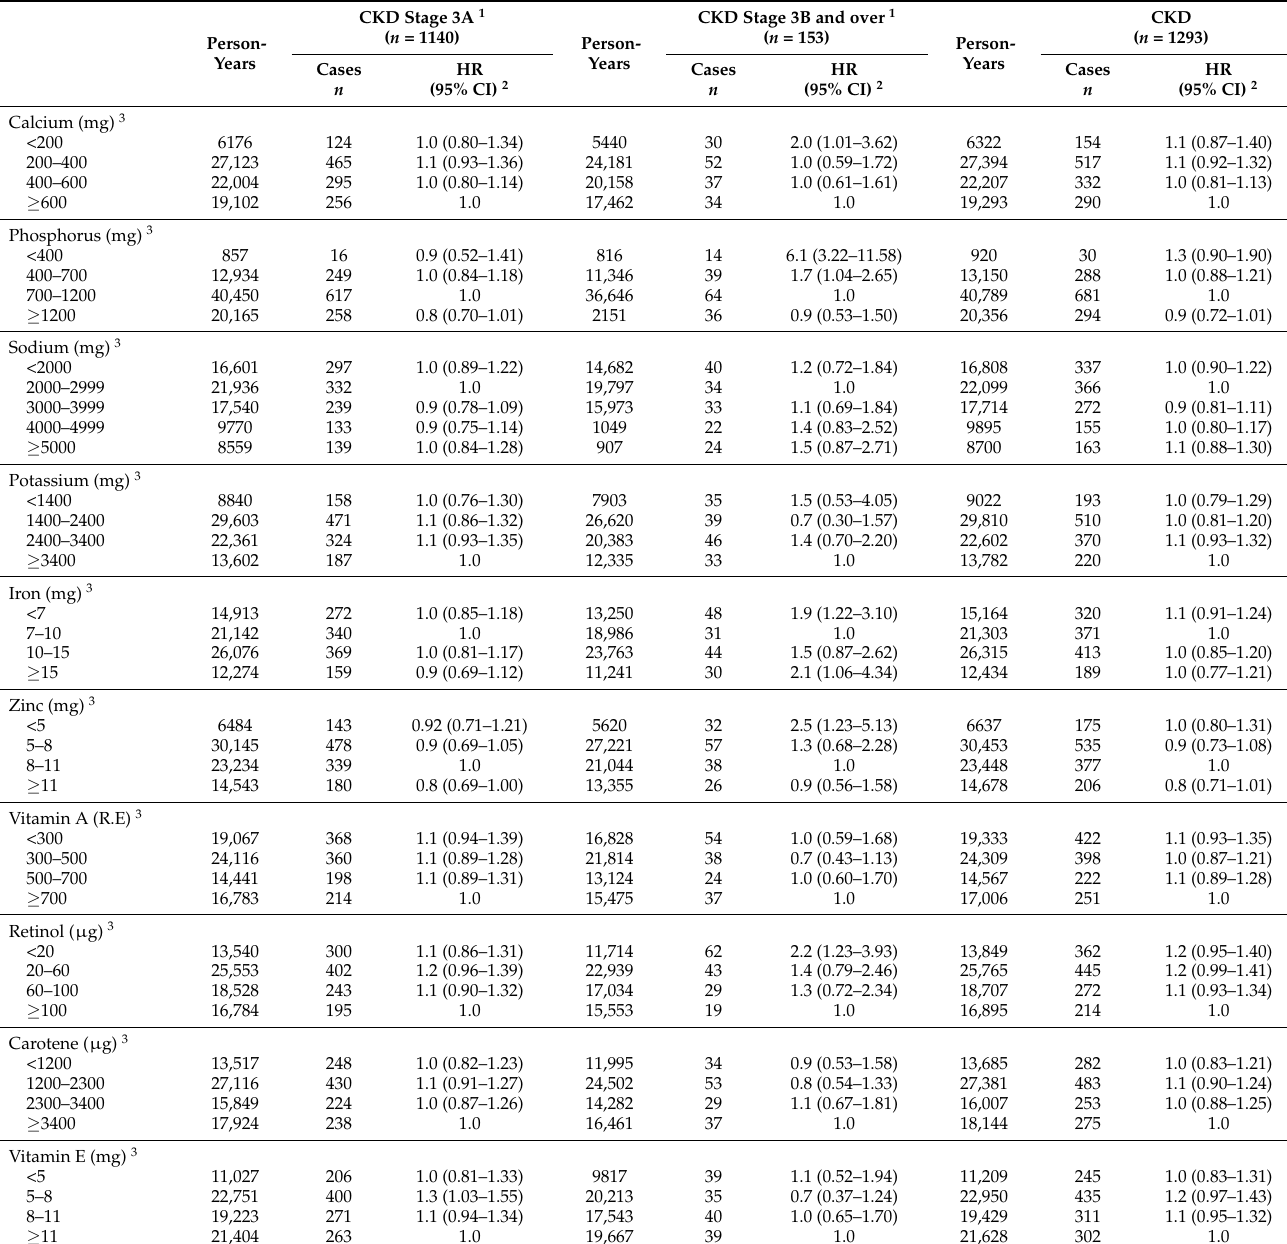
Table 1. Single-mineral intake for CKD 1 risk in the entire cohort population (the Ansan-Ansung KoGES) with 12 year follow-up ( n =